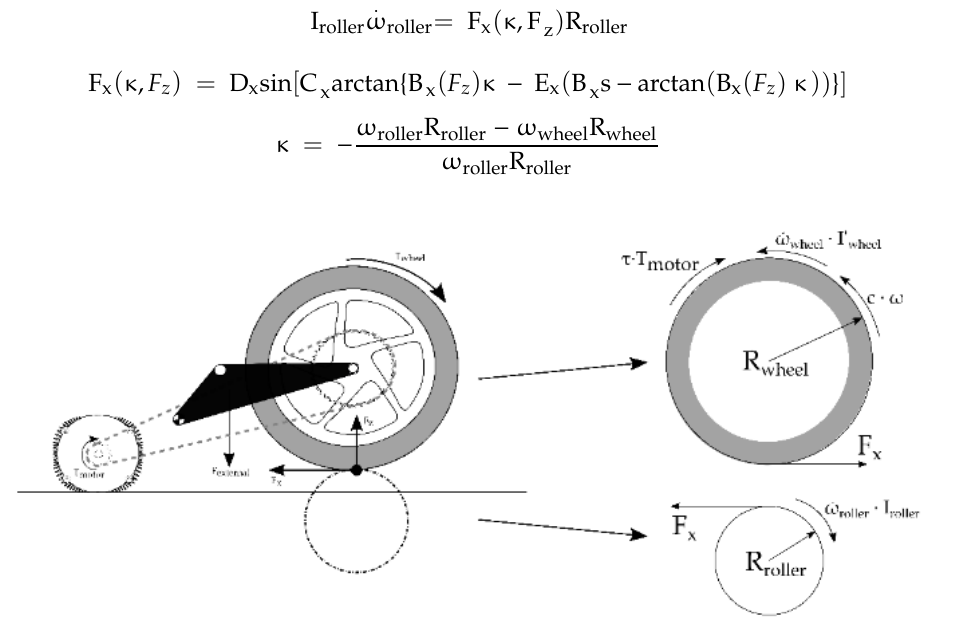
Figure 5. Free body diagram of the wheel and test bench roller.